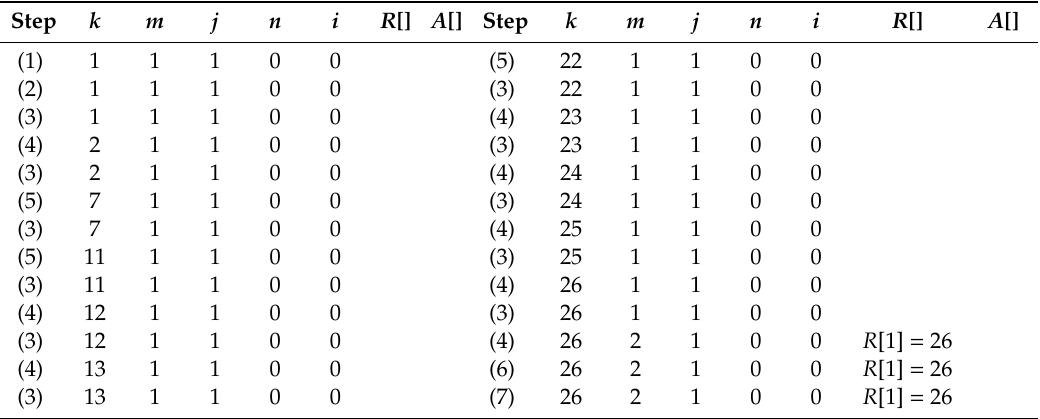
Figure 6. Iterative process of test case 1. Table 3. The operation steps of test case 1.